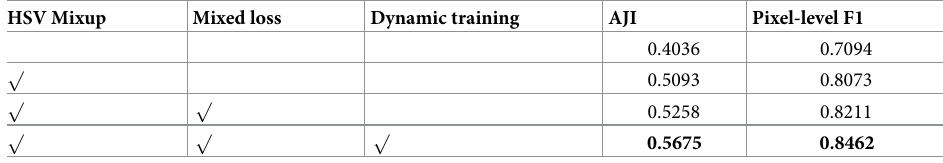
Table 5. Ablation experimental results of multiple training